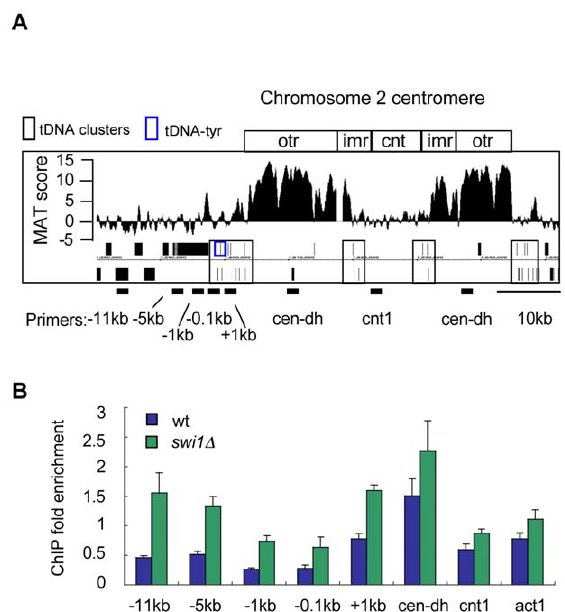
Figure6. c H2Aaccumulatesnear tDNAsinthe absenceof Swi1. (A) Detailed ChIP-on-chip distribution of c H2A near tDNA clusters bordering centromere 2. Boxed diagram above plot shows locations of centromere features: otr- outer repeats, imr- inner repeats, cnt – centromere core. Black boxes below plot represent genes. Location of qPCR primers are shown belowgraphandnamecorrespondtodistancefromtDNA TYR (B) ChIP-qPCR of c H2A near tDNA TYR in wild type and swi1 D cells.